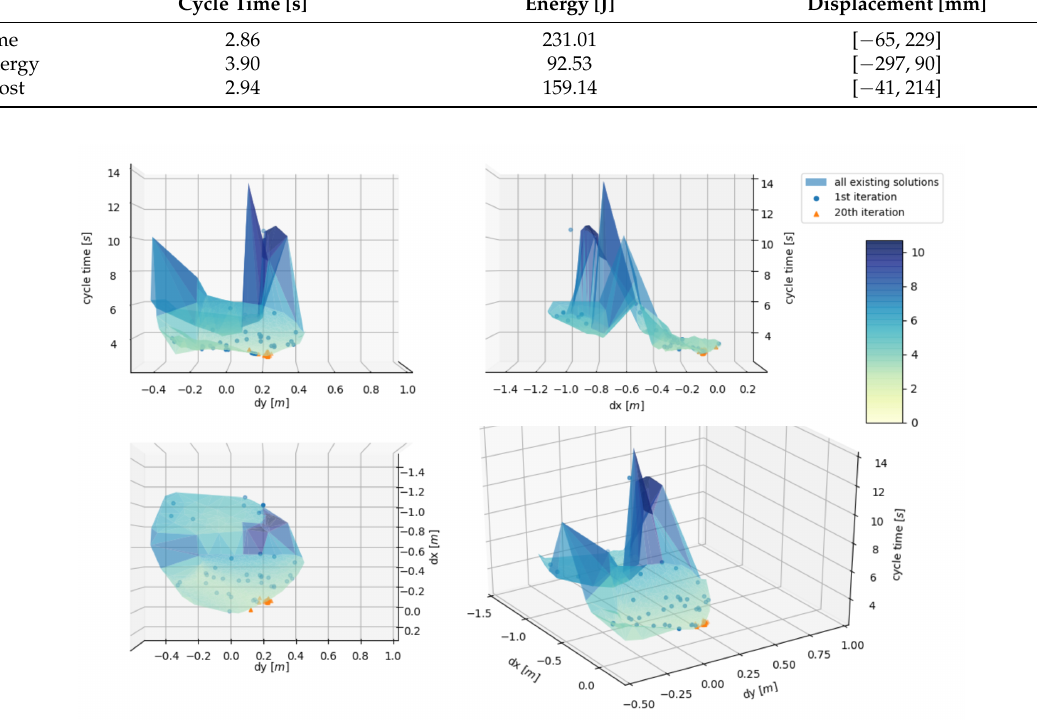
Figure 11. Specific cycle time in terms of the displacement vector of the robot base [ dx,dy ].